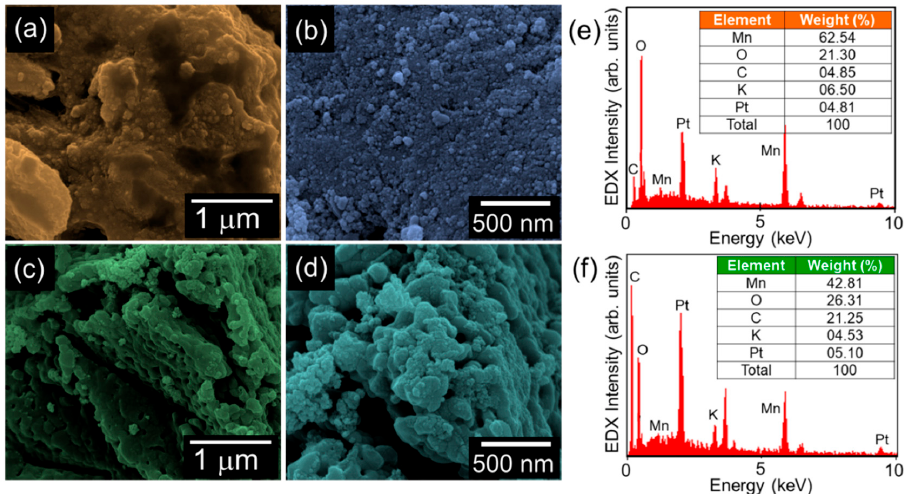
Figure 2. ( a ) Low- and ( b ) high-magnification FE-SEM images of MnO 2 nanoparticles. ( c ) Low- Figure 2. ( a ) Low ‐ and ( b ) high ‐ magnification FE ‐ SEM images of MnO 2 nanoparticles. ( c ) Low ‐ and ( d ) high ‐ magnification FE ‐ SEM images of MnO 2 ‐ AC nanocomposites. EDX spectra of ( e ) MnO 2 and ( d ) high-magnification FE-SEM images of MnO 2 -AC nanocomposites. EDX spectra of ( e ) MnO 2 nanoparticles and ( f ) MnO 2 ‐ AC nanocomposites. nanoparticles and ( f ) MnO 2 -AC